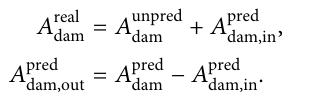
Figure 10: Truncated damage index charts of the preliminary damaged area using a damage threshold of 40% Z max 4%, (c) Mesh 2%, and (c) Mesh